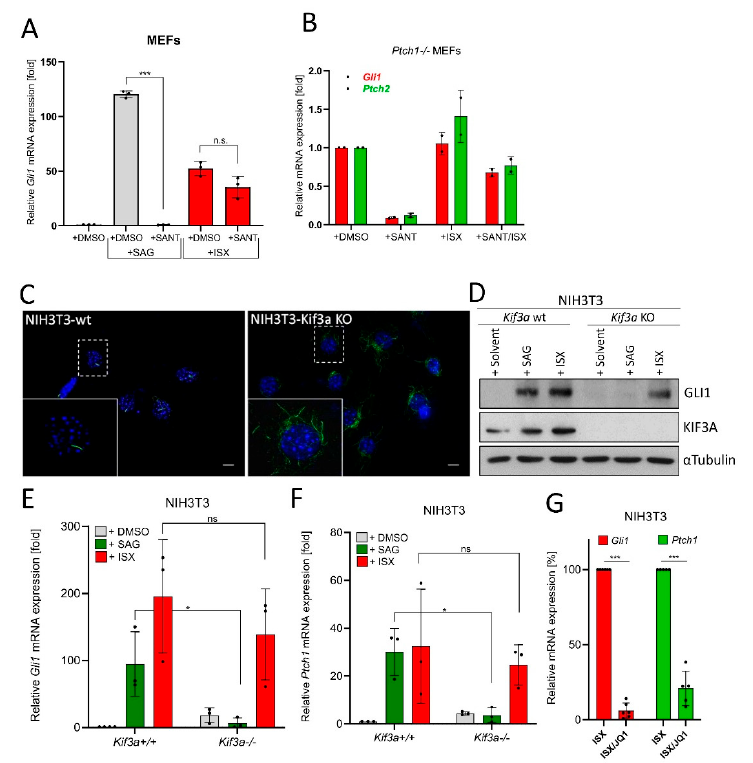
Figure 4. ISX functions independently of primary cilia. ( A ) Expression of the Hh target gene Gli1 in MEFs as measured by qPCR. Cells were treated with ISX (20 µM), SANT1 (0.2 µM) or SAG (100 nM) for 48 h. Shown is the mean of n = 3 ± SD. ( B ) Expression of the Hh target gene Gli1 and Ptch2 in Ptch1-/- MEFs as measured by qPCR. Cells were treated with ISX (20 µM), SANT1 (0.2 µM) or SAG (100 nM) for 48 h. Shown is the mean of n = 2 ± SD. ( C ) Primary cilia (AcTub, green) in wildtype (wt) and Kif3a knockout (KO) NIH3T3 cells. Nuclei appear in blue (DAPI). Scale bar is 10 µm. ( D ) Immunoblot depicting the protein levels of GLI1 and KIF3A in Kif3a wt/KO NIH3T3 cells. Treatment was for 48 h with 100 nM SAG or 20 µM ISX. Shown is one of three independent experiments. Tubulin was used for normalization. ( E ) Expression of Gli1 in Kif3a wt/KO NIH3T3 cells. Treatment as in ( D ). Mean of n = 3 ± SD. ( F ) Expression of Ptch1 in Kif3a wt/KO NIH3T3 cells. Treatment as in ( D ). Mean of n = 3 ± SD. ( G ) Expression of Gli1 and Ptch1 in NIH3T3 cells treated with ISX (20 µM) or ISX (20 µM)/JQ1 (1 µM) for 48 h. The ISX-induction was set to 100%. Mean of n ≥ 5 ± SD. Significances were indicated as ns (not significant; p > 0.05), * p < 0.05, *** p < 0.001.